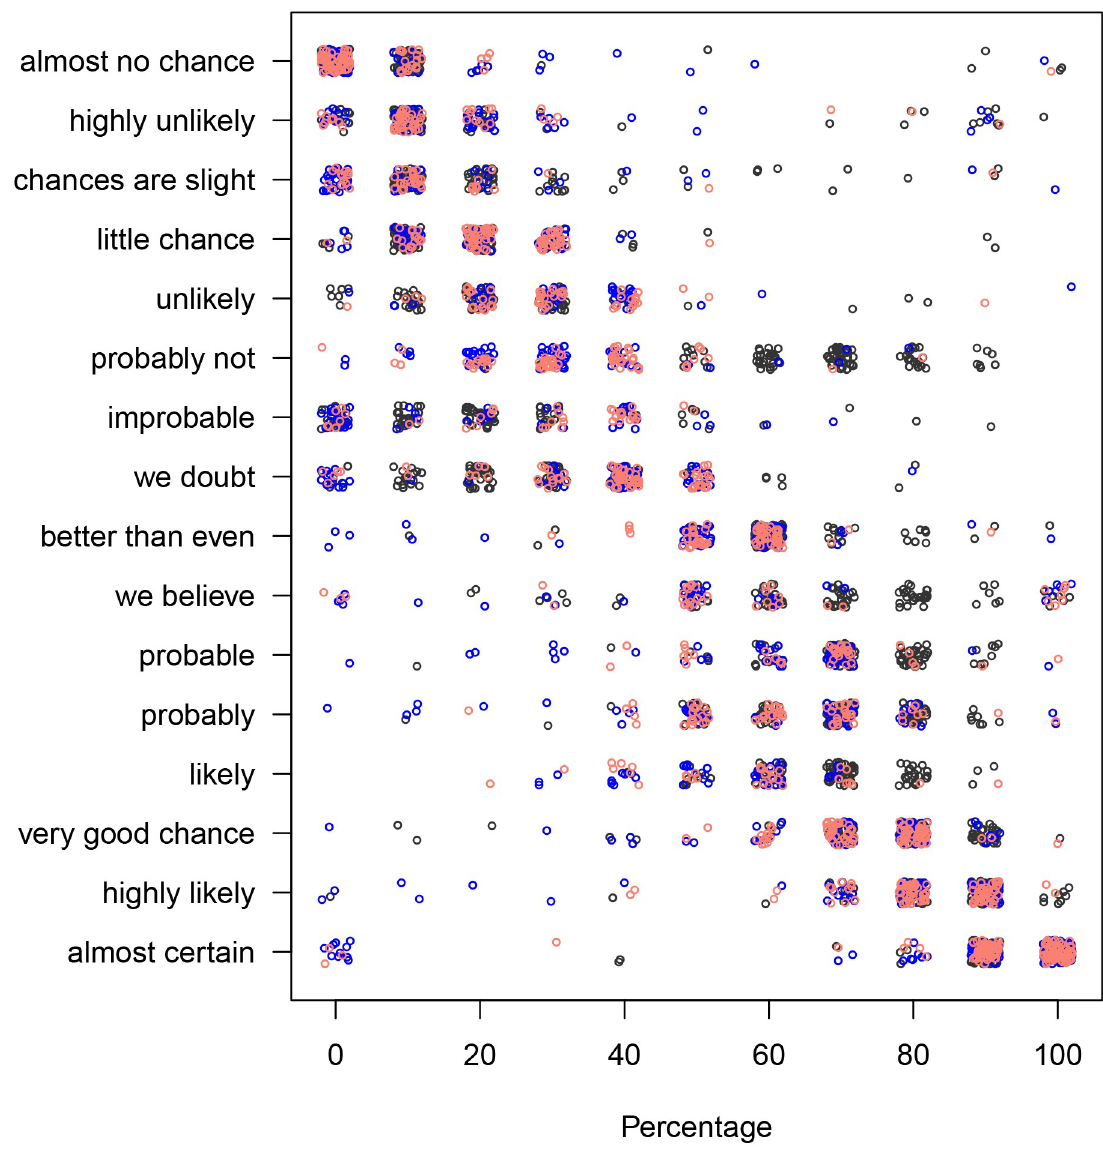
Fig 5. The phrases associated with the percentages, using the “uncertainty” prompt. The black, blue, and red colours correspond to the context-free, user and car contexts, respectively. Each dot represents one response.